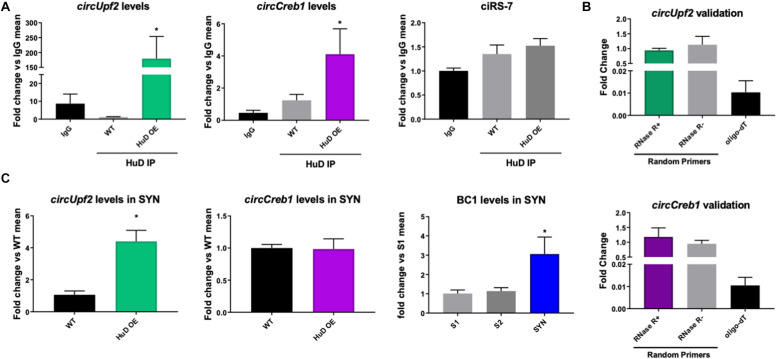
HuD binds to circUpf2 and circCreb1 in vivo. (A) The interaction between HuD and the circRNAs derived from the Upf2 and Creb1 genes was confirmed by HuD RIP vs. WT control RIP followed by circRNA-specific qRT-PCR assays. Values are expressed as fold change vs. IgG controls. Mmu_circ_CiS-R7 was used as negative control. Data were analyzed by a One-way ANOVA, followed by Dunn’s Multiple Comparison Test and expressed as mean ± SEM; *p < 0.05, n = 3. (B) Validation of specific amplification of circRNAs by qRT-PCR using RNAse R to pretreat the RNA to degrade all linear RNAs and random primers vs. oligodT to amplify circRNAs vs. mRNAs. n = 3. (C) Total RNA from synaptosomes extracts from the mouse striatum were processed as described in section “Materials and Methods” and subjected to qRT-PCR for circUpf2 and circCreb1. Values were normalized to GAPDH mRNA levels and expressed as fold change vs. WT controls; BC1 RNA levels differences between S1, S2 and synaptosomes fraction (SYN) were used to validate synaptosome (SYN) purification as previously described (Rao and Steward, 1991). Data was analyzed by Student t-tests (circUpf2 and circCreb1) and One-way ANOVA (BC1). Values represent mean ± SEM; *p < 0.05, n = 3.